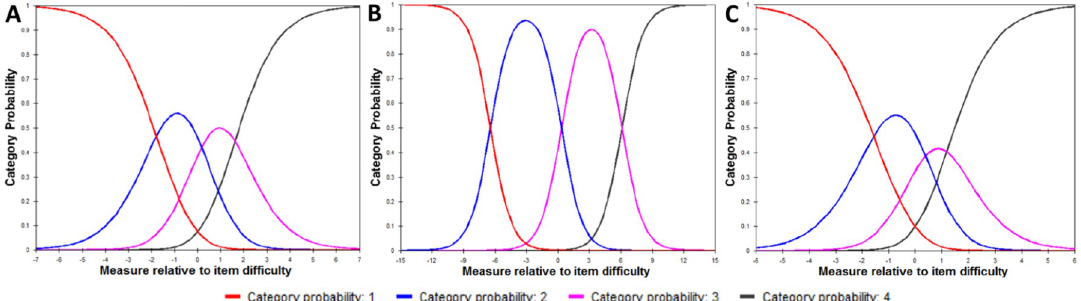
Fig 1. Category probability curves for Catquest-9SF. A) all 9-items, B) global assessment items Ca and Cb only, and C) daily-life activities items C1-C7 only.